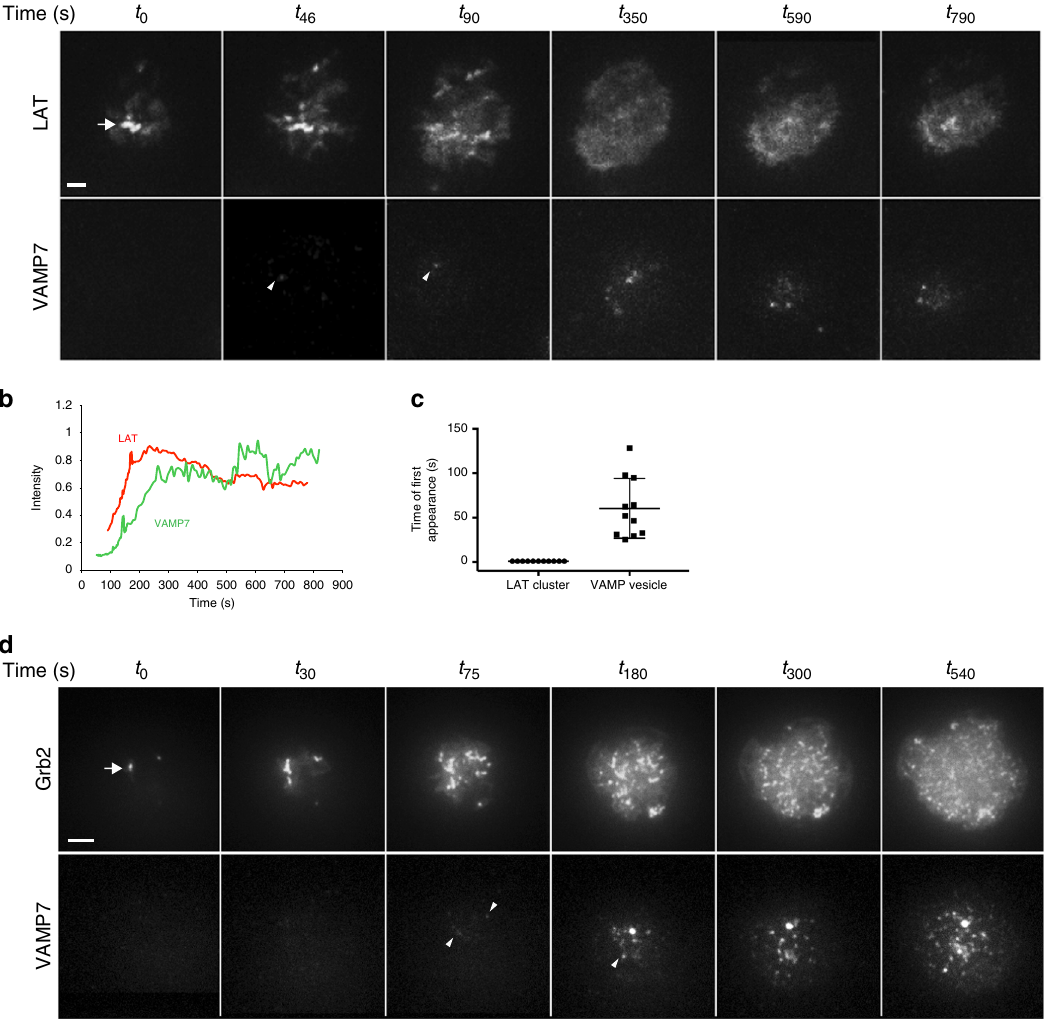
Fig. 2 Microcluster formation precedes VAMP7 recruitment as visualized by TIRF microscopy. a Jurkat cells transfected with LAT-RFP and GFP-VAMP7 were dropped onto stimulatory coverslips and imaged by TIRF microscopy. b Intensity pro fi le of LAT-RFP and GFP-VAMP7 over time. c Time of appearance of LAT-RFP or GFP-VAMP7 signal in TIRF fi eld ( n = 12 cells, three independent experiments). d Jurkat cells transfected with Grb2-apple and emerald- VAMP7 were dropped onto stimulatory coverslips and imaged by TIRF microscopy ( n = 10 cells, three independent experiments). a , d Top panels show LAT and Grb2, respectively, and arrows point to early microclusters; bottom panels show VAMP7, and arrowheads point to vesicles touching down. Scale bars = 2 μ